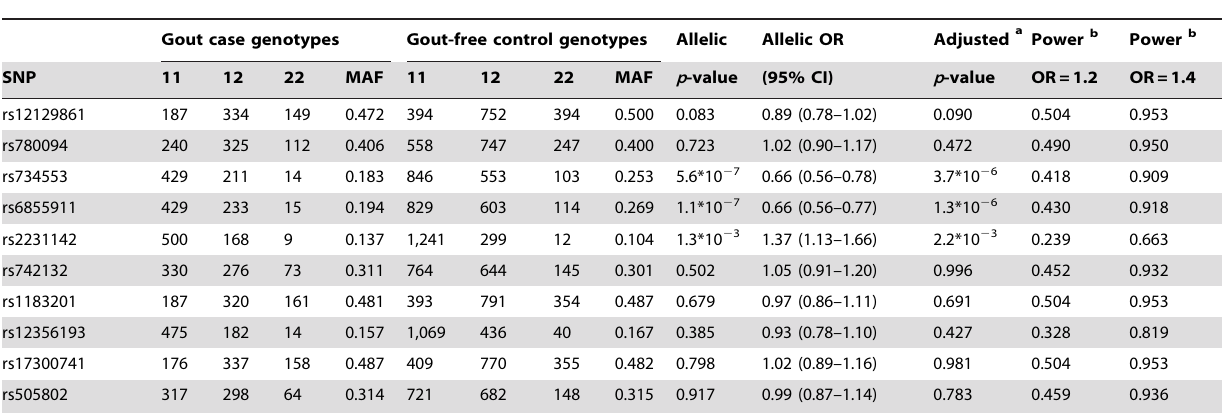
Table 4. Association analysis results in gout case-control